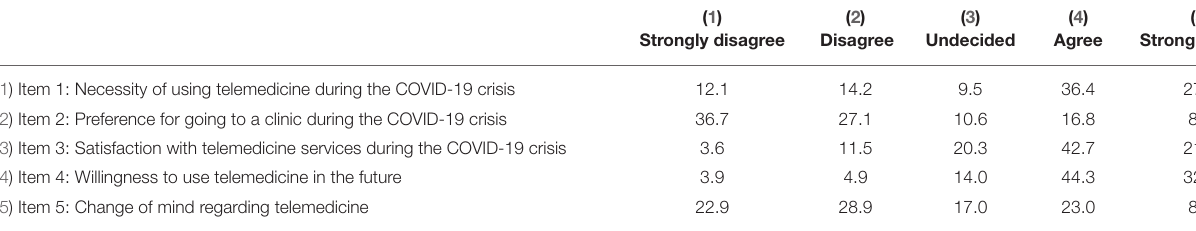
TABLE 2 | Participants’ responses (%) to the five-item questionnaire ( N = 693).